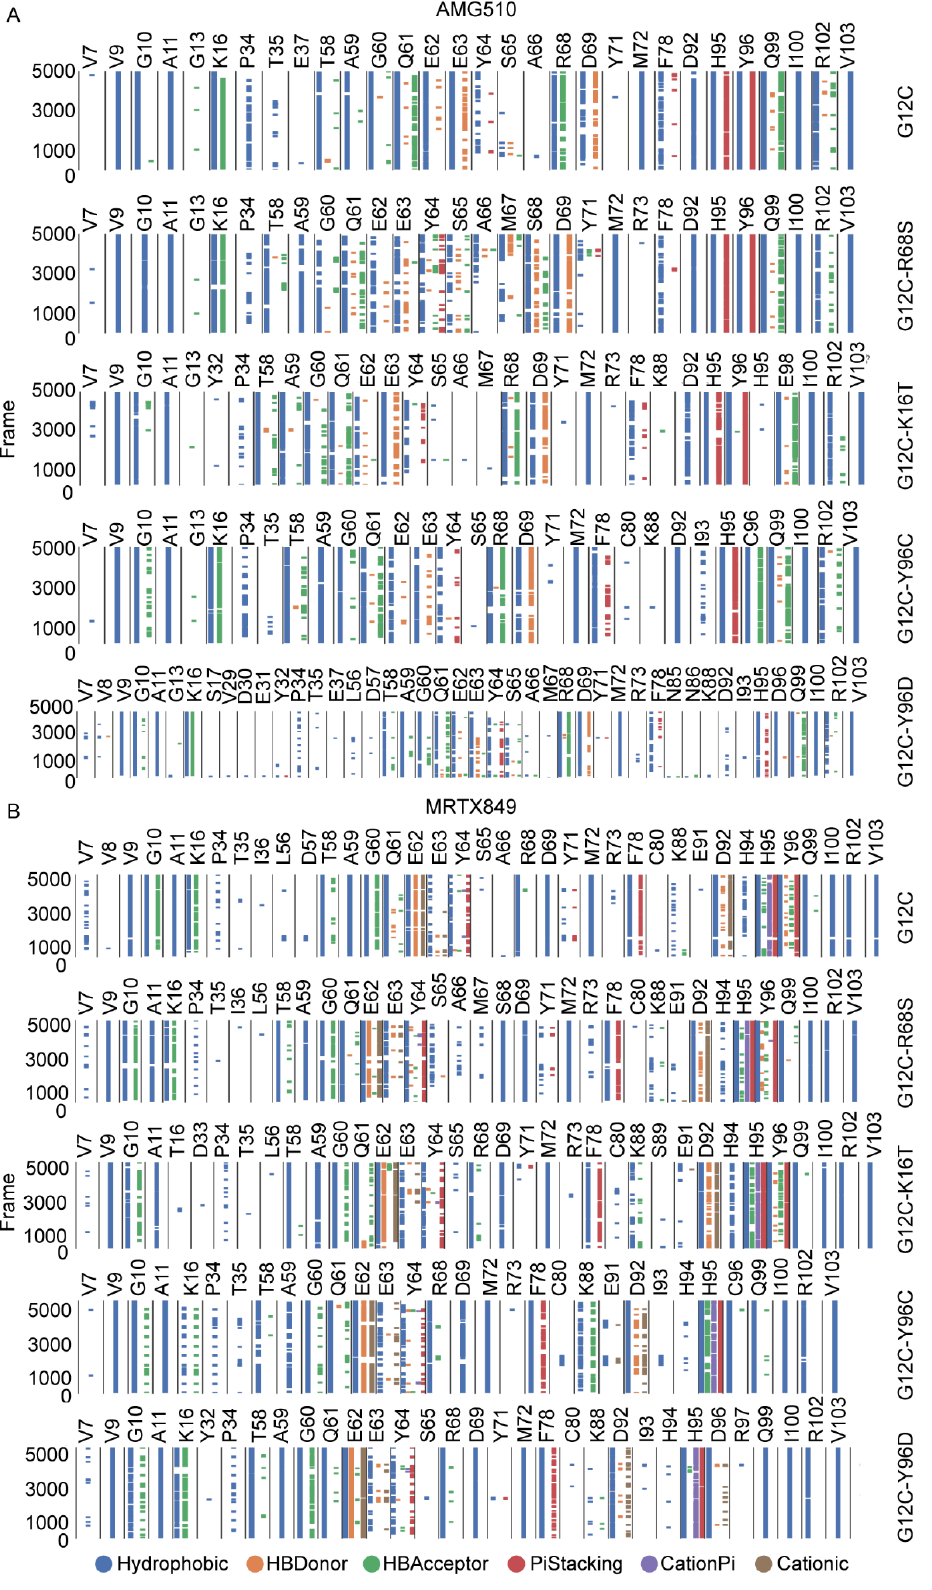
Figure 11. Interaction fingerprints of AMG510 ( A ) and MRTX849 ( B ) with mutated KRAS during MD simulation. Each of the interaction types is colored by different color.